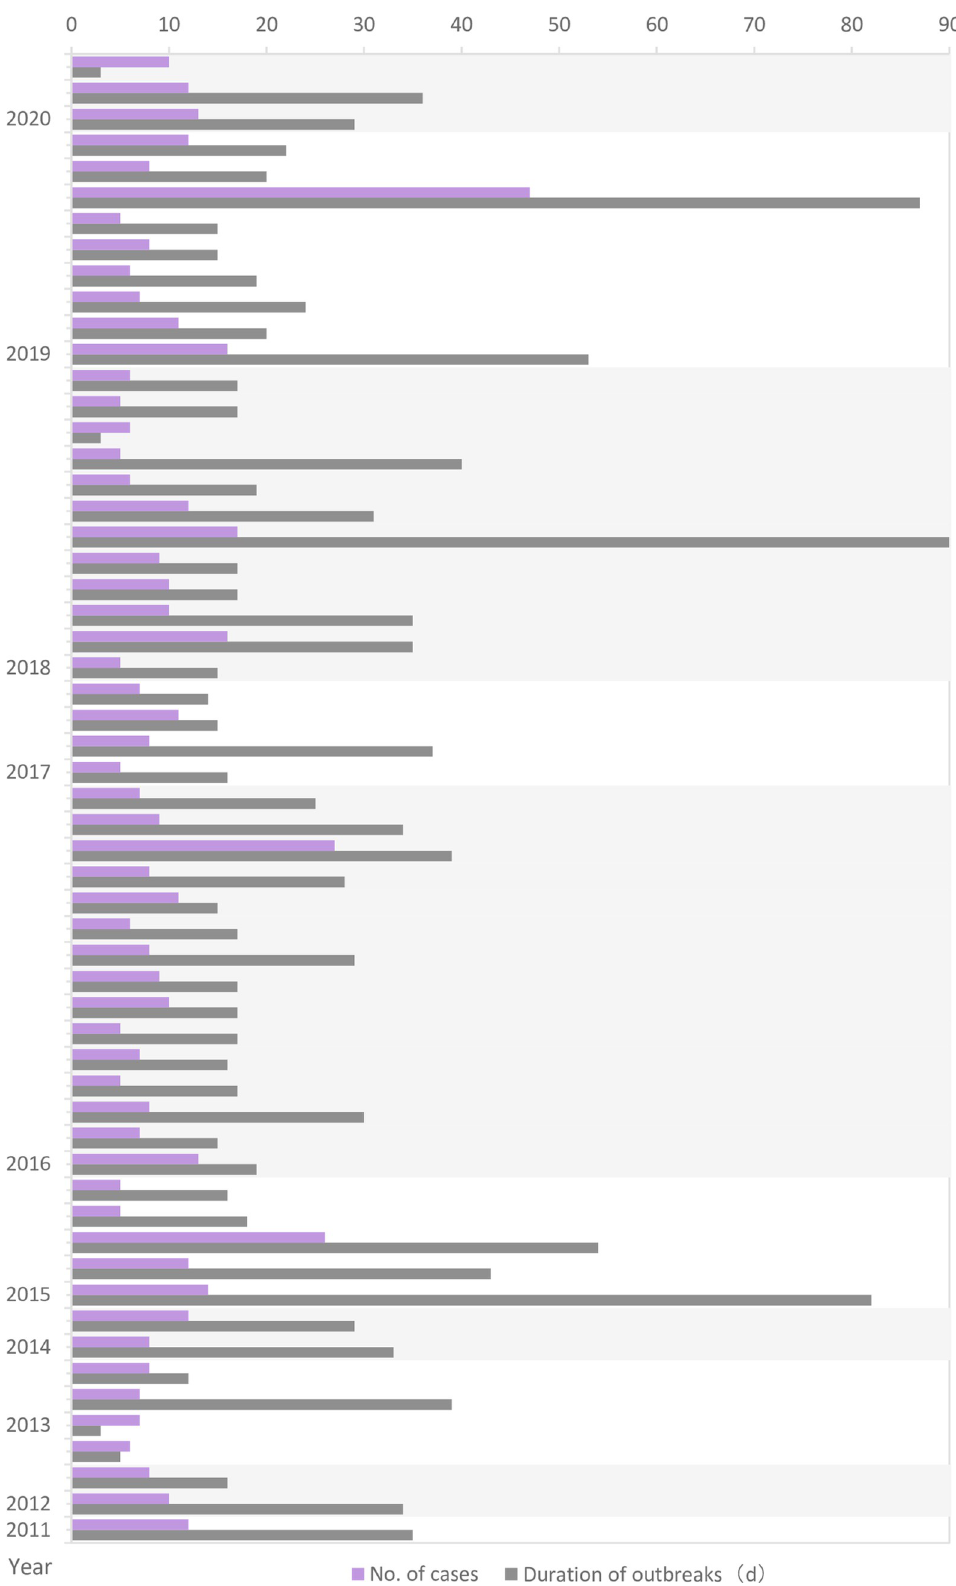
Fig 1. Scale and duration of varicella outbreaks in Huangpu District, Shanghai, China from 2011–2020. https://doi.org/10.1371/journal.pone.0270630.g001 PLOS ONE | https://doi.org/10.1371/journal.pone.0270630 June 30,